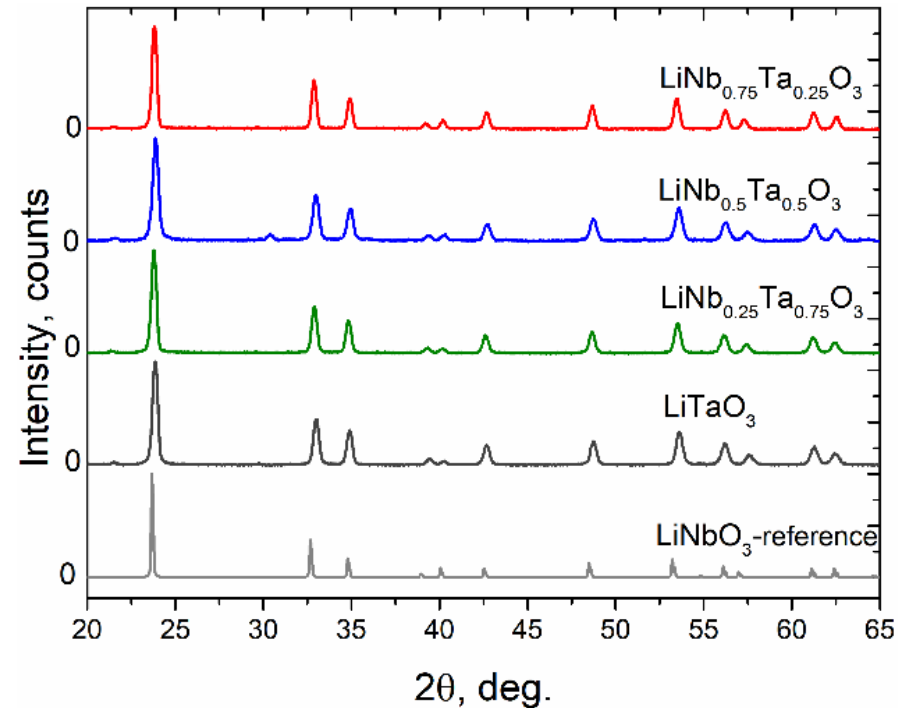
Figure 8. Diffraction patterns of LiNb 1 − x Ta x O 3 nanopowders ( x = 0.25; 0.5; 0.75; 1) obtained